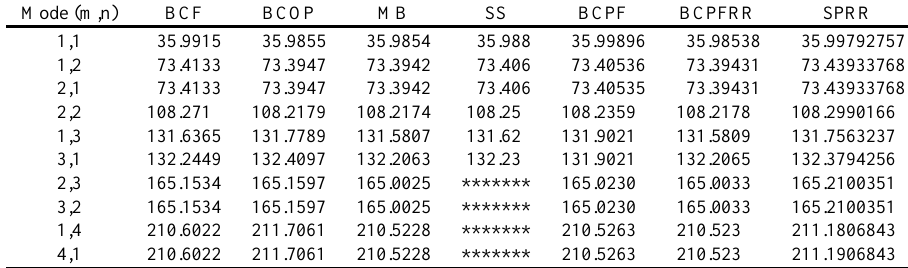
(cid:5) Table 1 m/D , α = 1 , ν = 0 . 3 . BCF, beam